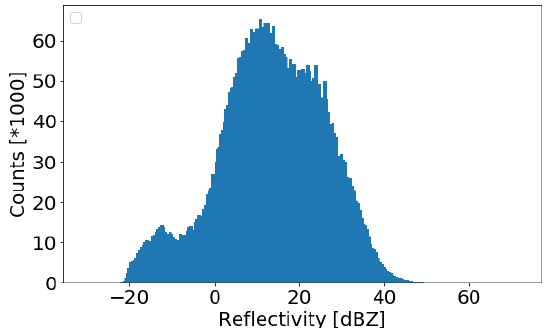
Figure 8. Histogram of radar reflectivity (dBZ). Note that the counts of the minimum values at − 30dBZ (representing the low- est measured reflectivity) were removed (i.e. 41691984